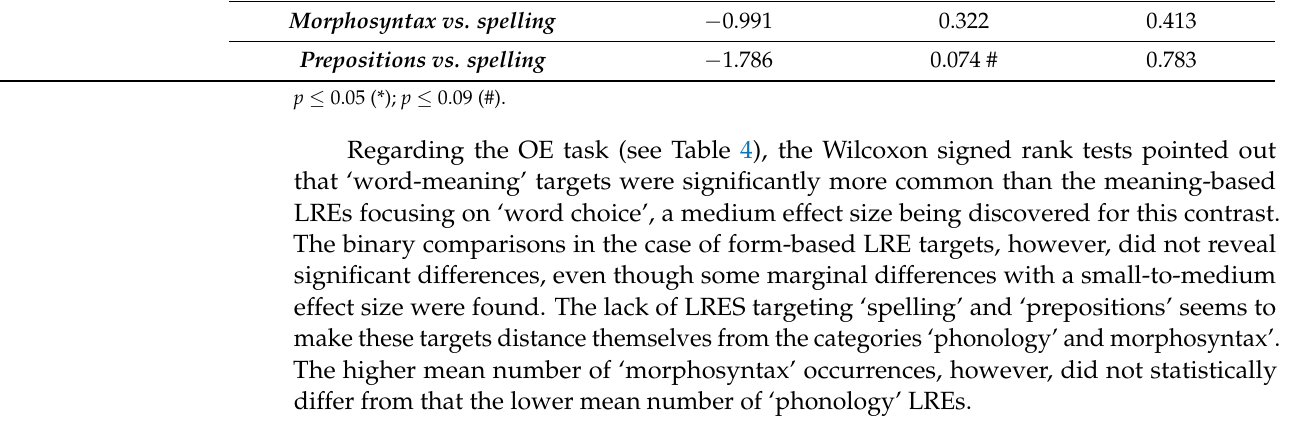
Table 4. Target comparisons for the production of LREs in the OE